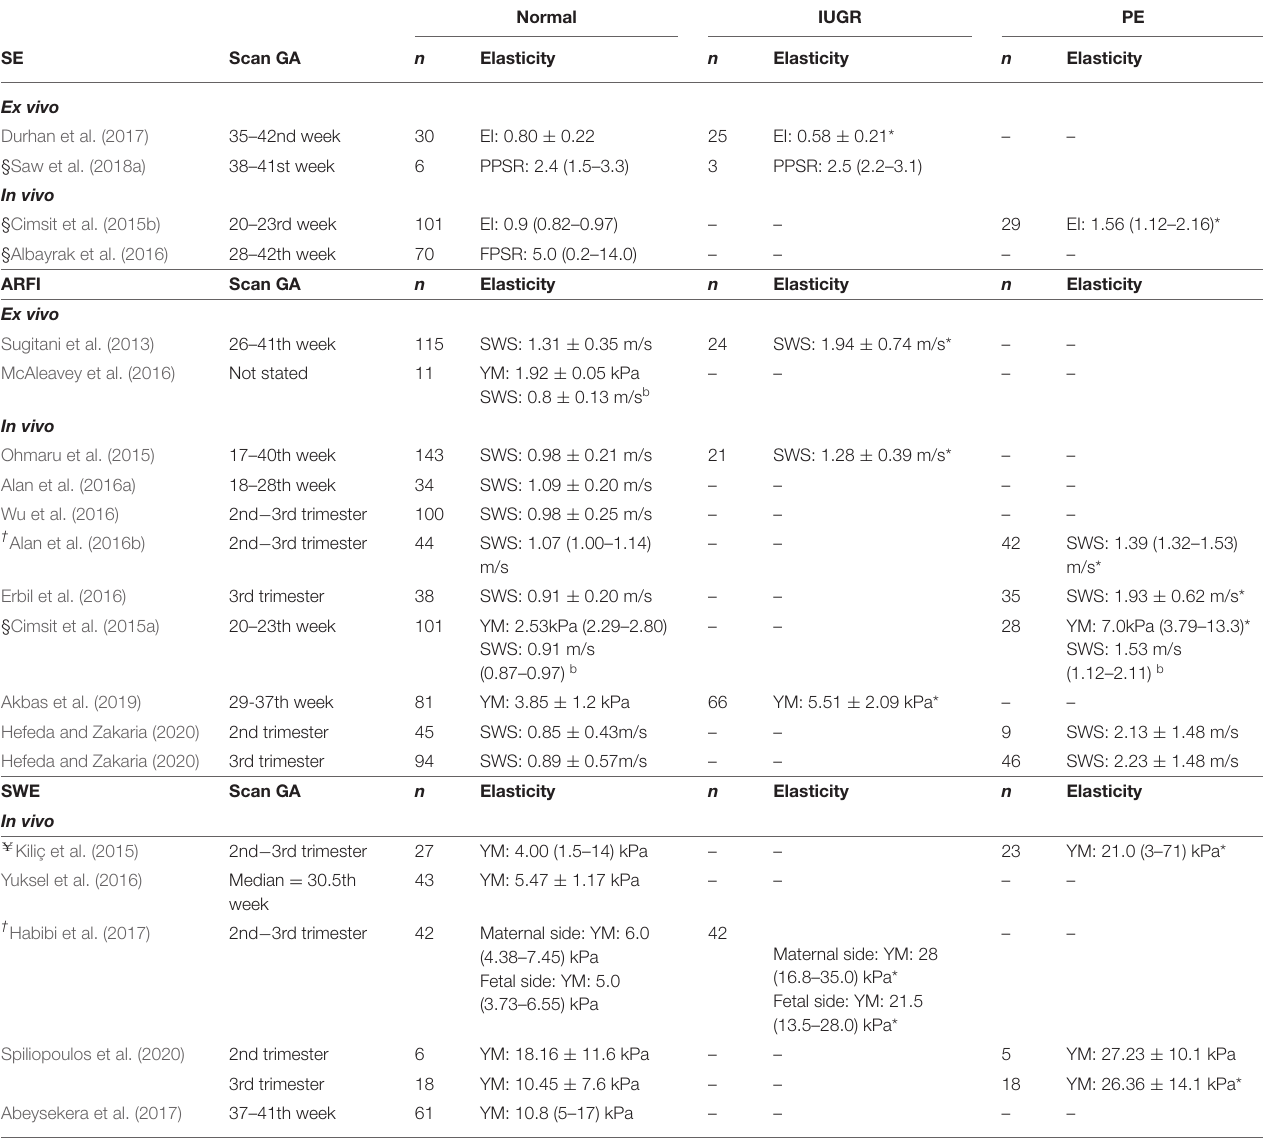
TABLE 1 | Elastography measurements on human